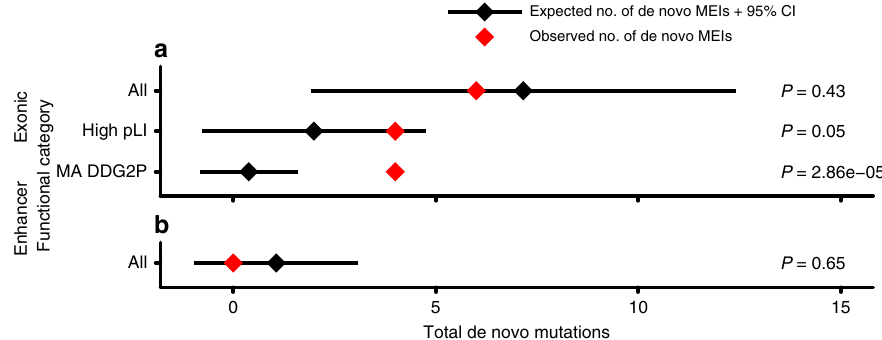
Fig. 4 Estimating enrichment of deleterious MEIs. Depicted are the total number of expected (black) and observed (red) de novo mutations observed in exons ( a ) and enhancers ( b ) for all, high pLI (pLI > 0.9), and known monoallelic DD (MA DDG2P) genes. Expectation is based on the Poisson distribution of 100 simulations utilizing the neutral mutation rate (1.2 × 10 – 11 μ ). P -values are based on the Poisson distribution and used to determine statistical deviation of observed to expected de novo counts for exons and